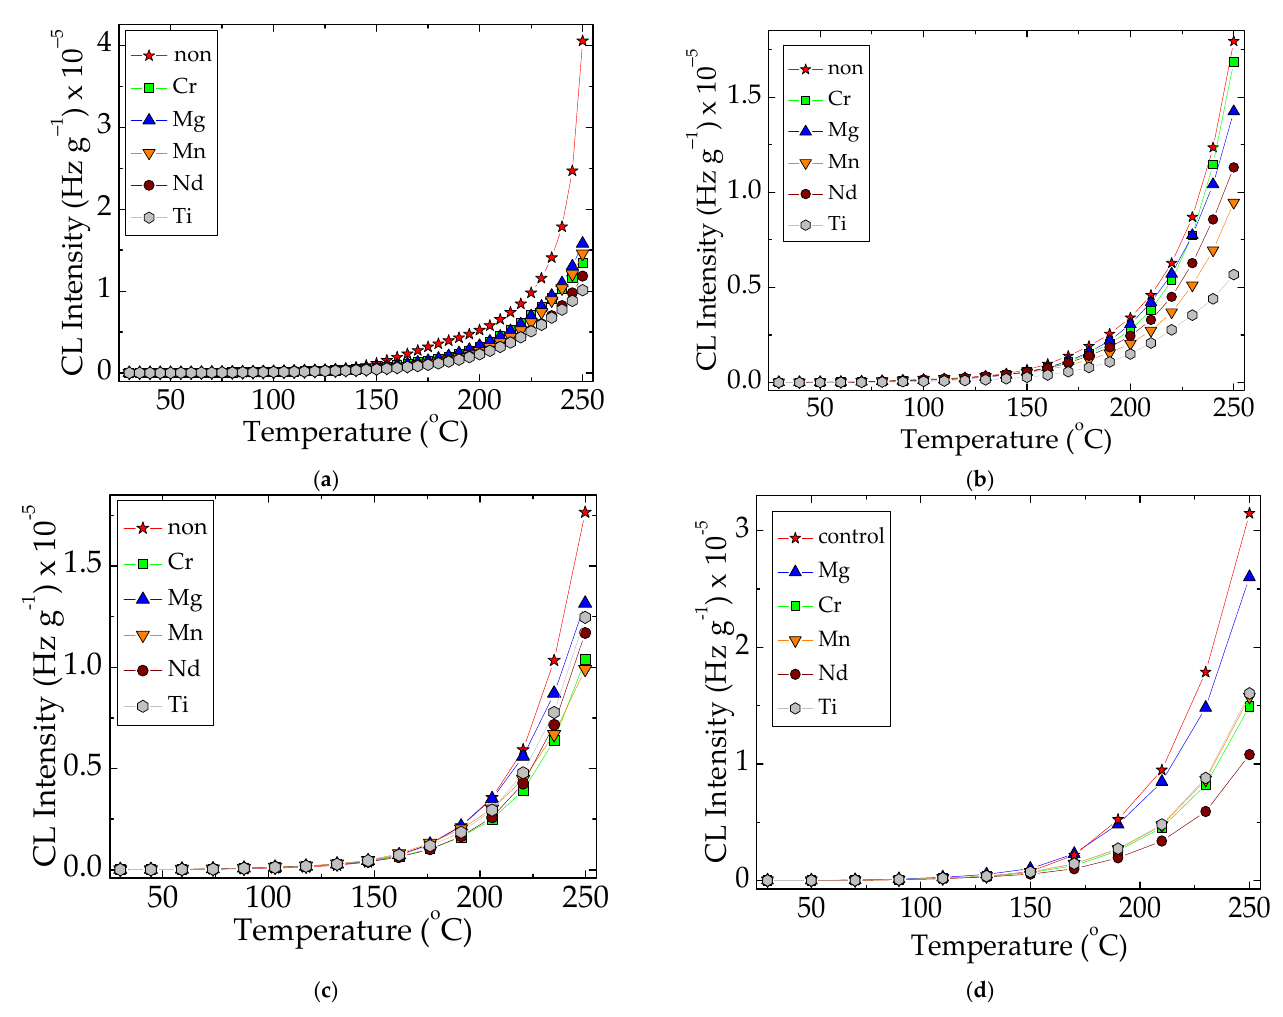
Figure 7. Nonisothermal CL spectra recorded on the PCL samples containing PbZrO 3 doped with various metallic atoms at different heating rates: ( a ) 5 °C min − 1 , ( b ) 10 °C min − 1 , ( c ) 15 °C min − 1 , and ( d ) 20 °C min − 1 .